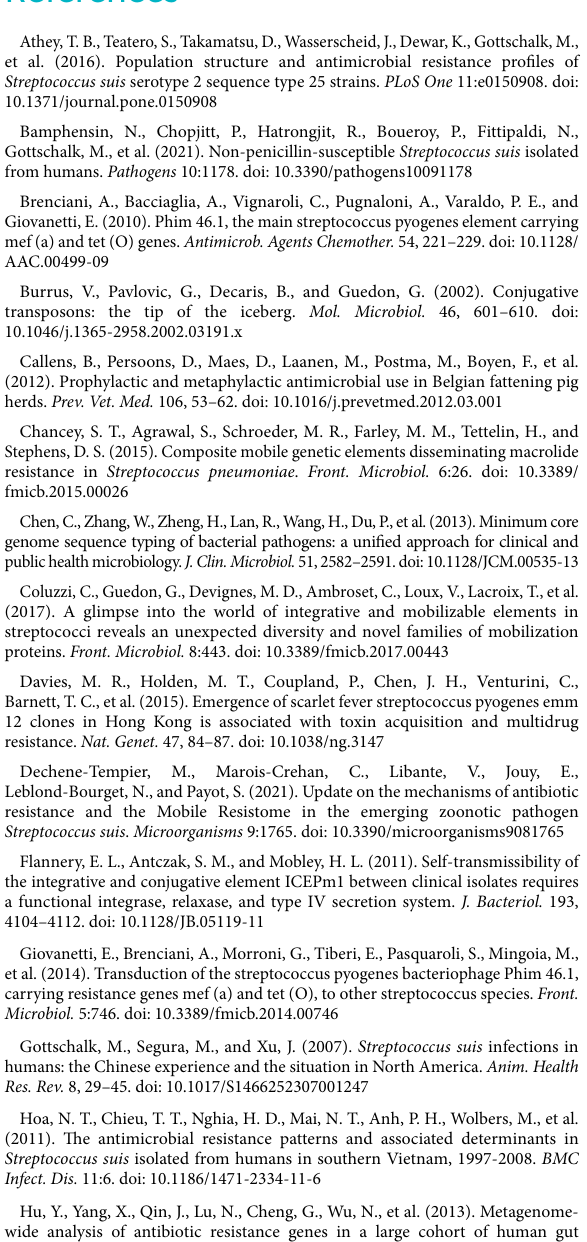
arrow indicates the direction of transcription. Regions of >90% and 80%-90% identity are marked by pink and blue shading, respectively. The integrase gene, relaxase gene, snf2 gene, AR genes, and T4SS of ICEs are indicated by different colors. CIMEs, Tn916, and the 15K fragment are highlighted in a red box. The AR genes and Tnpv genes of CIMEs and the 15K fragment are indicated by different colors. The rplL and hdy genes are located in the flanking regions of the ICEs. SUPPLEMENTARY TABLE 1 The information of the genomes and AR genes carried in the present study. SUPPLEMENTARY TABLE 2 The primers used in the present study for the circular ICEs